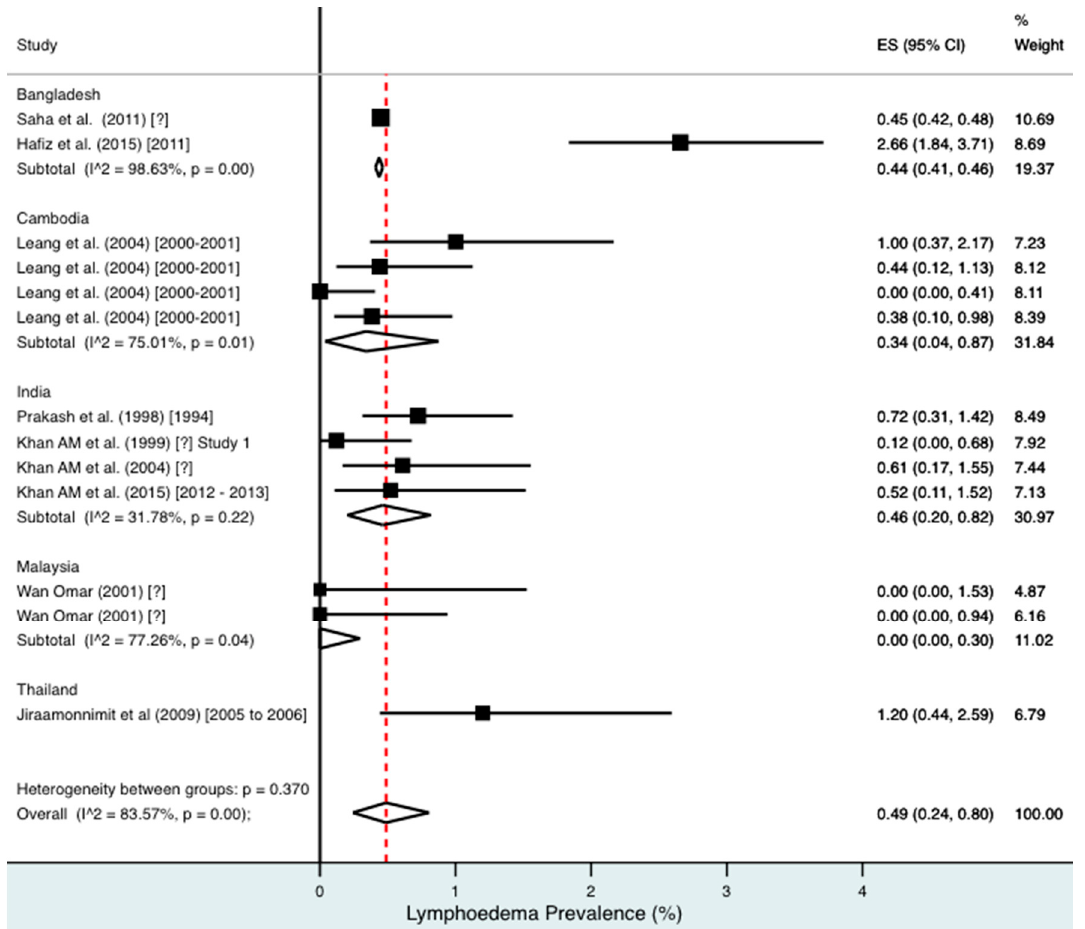
Figure 6. Percentage estimates of lymphoedema prevalence by country and year. ES: prevalence estimate. Red-dotted line: overall estimate. Diamond: sub-group estimate. Horizontal line: 95% CI.